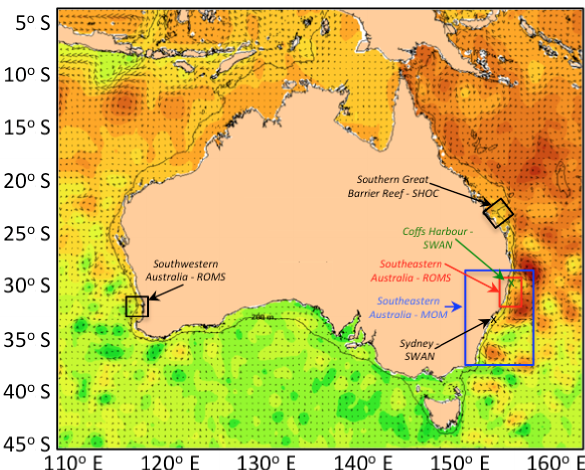
Figure 4. Map of Australia, showing the sea level (colour) and geostrophic surface velocities (from http://oceancurrent.imos.org. au), with the approximate locations of each model domain used for testing. Labels, arrows, and boxes are colour-coded for clarity off eastern